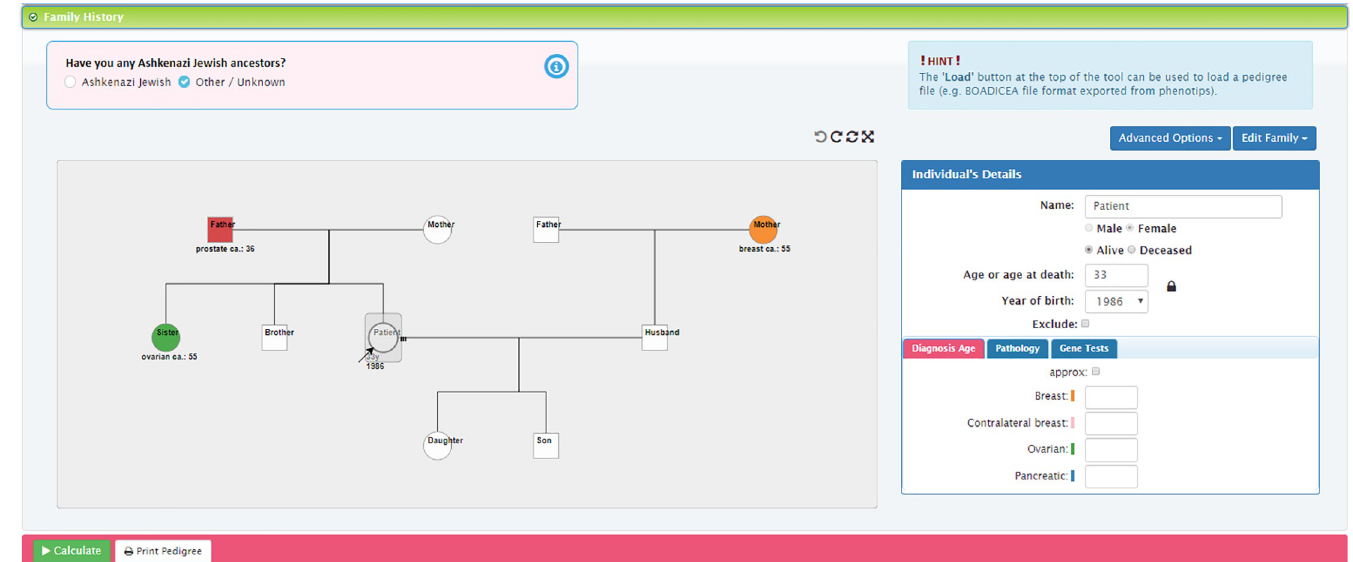
Fig 3. CanRisk tool detailed view of the interactive graphical pedigree editor [16] � . � image corresponds to the revised version of the tool (not the beta version